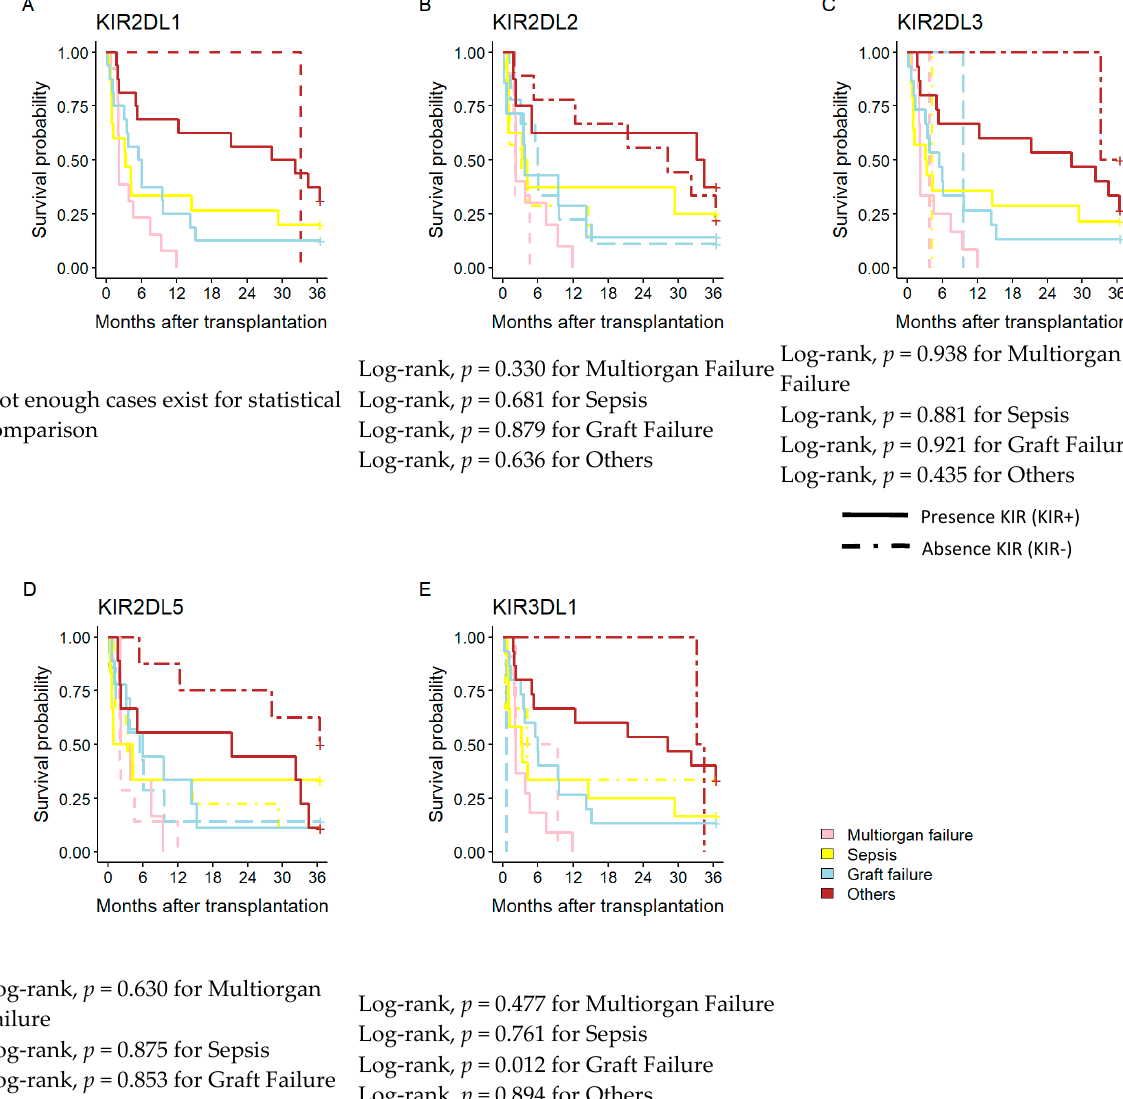
Table 4. Cox regression multivariable analysis for AC patients’ survival.